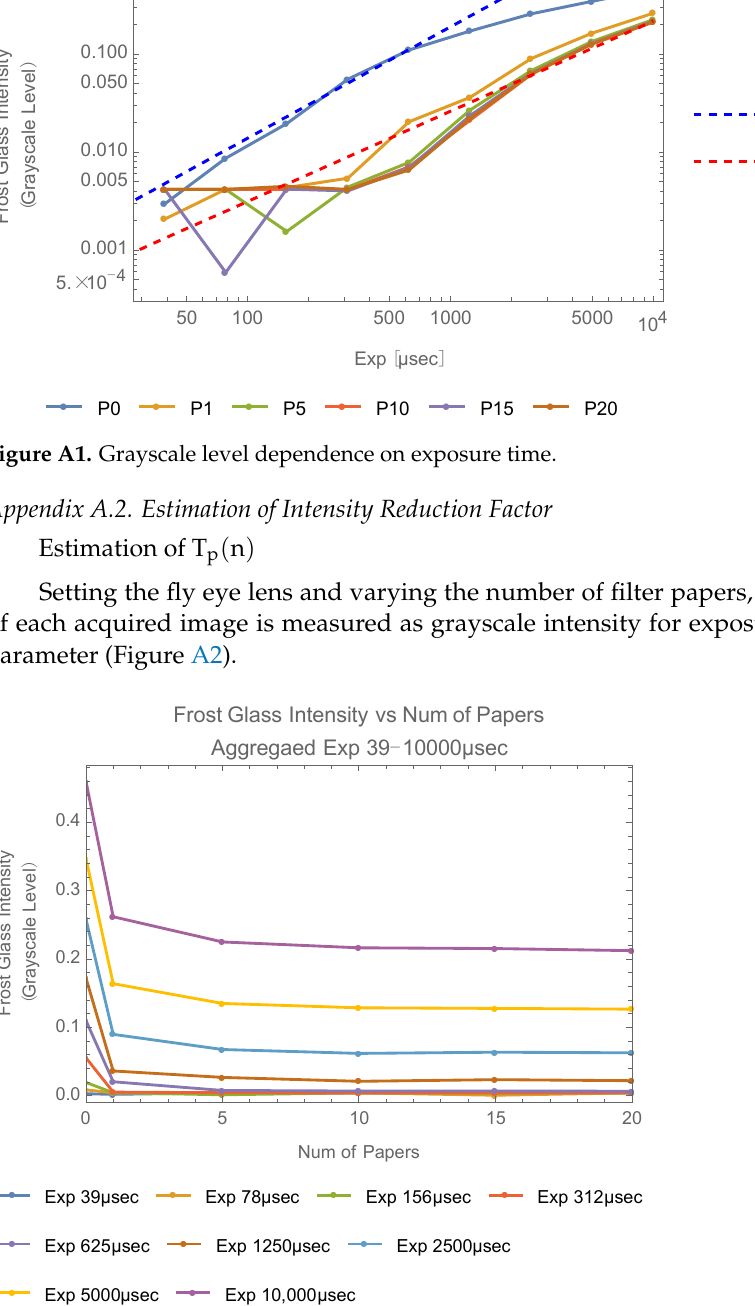
Figure A2. Frost glass intensity. As the number of the filter papers increases, each grayscale level approaches a con- stant value. From Figure A2, this value is confirmed to be monotonically increasing with exposure time. This is regarded as the background. Let n be the number of filter papers